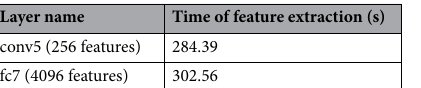
Table 5. Time required for feature extraction from the conv5 and fc7 layers.